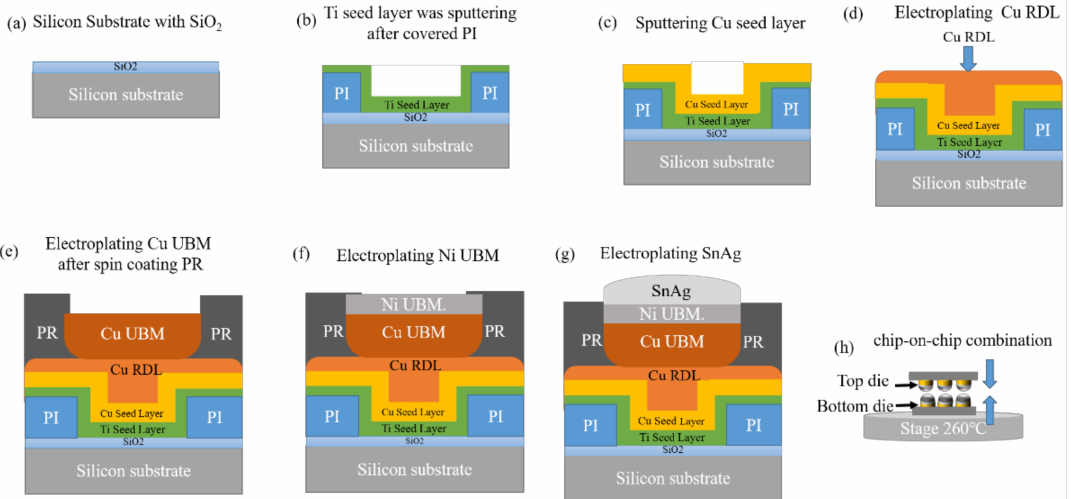
Figure 1. Flow chart of the sample fabrication: ( a ) 8-inch wafer as substrate; ( b ) sputtering PI and Ti seed layer; ( c ) sputtering Cu seed layers; ( d ) electroplating the Cu RDL; ( e ) electroplating Cu UBM after spin-coating PR; ( f ) electroplating a Ni UBM layer; ( g ) electroplating SnAg; ( h ) flip-chip solder joints were bonded by thermal